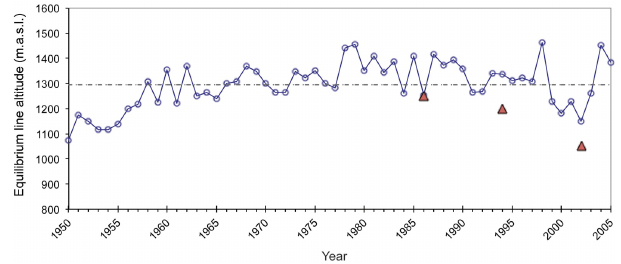
Fig. 9. Annual equilibrium line altitude (ELA) derived from daily snowline and the mass balance model using input scenario #4 in Ta- ble 2, from 1950–2005 (black line) and measured ELAs in 1986, 1994 and 2002 (also derived from late summer snowline) (trian- gles). Mean modeled ELA for the period 1960–2005 is